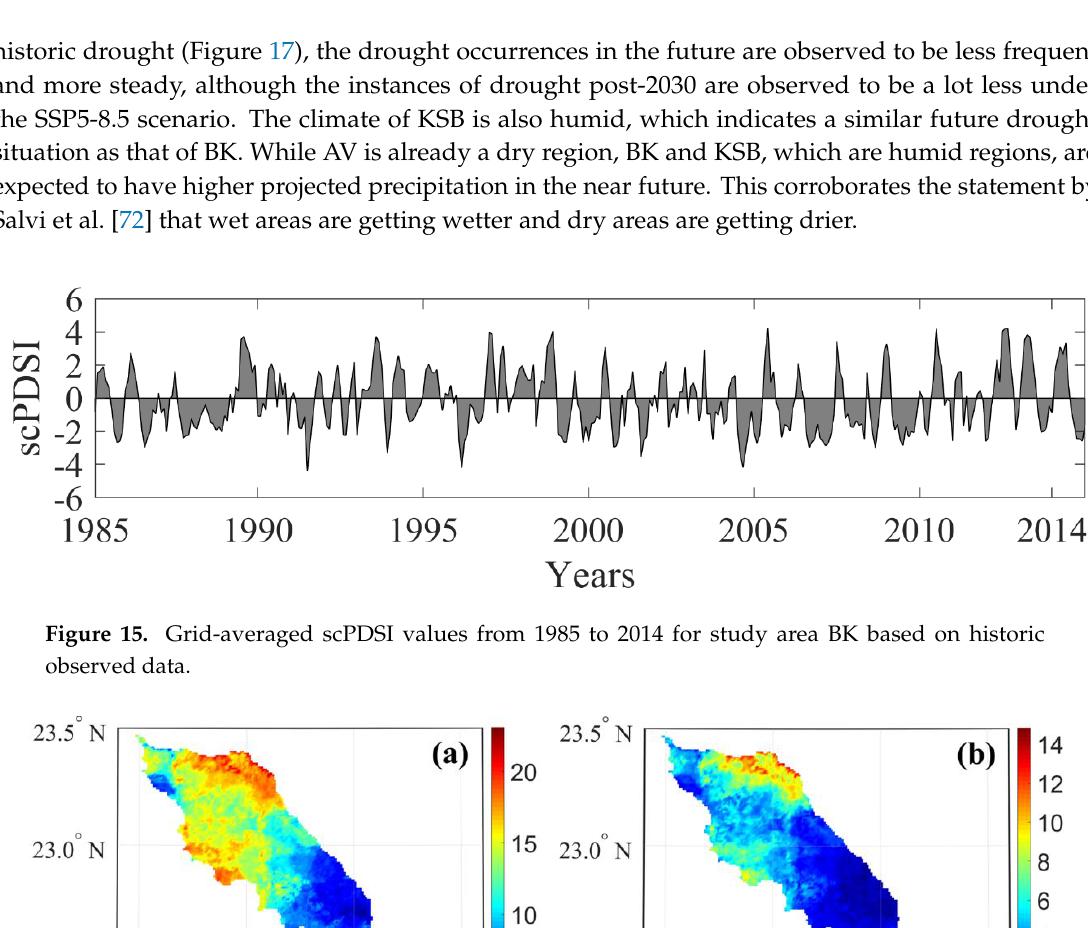
Figure 16. Drought duration maps for historic observed data for study area KSB. ( a ) For severe drought and ( b ) for extreme drought. The scale bar represents months of drought in historic 30 years (1985–2014).